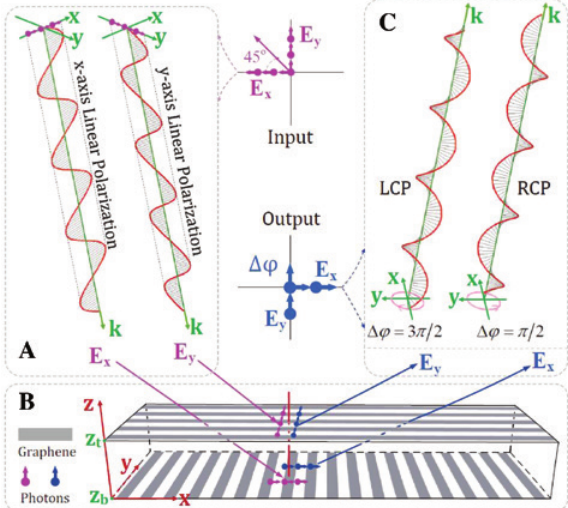
Figure 20: Dependence of the linear phase difference Δ φ on z determined for different values of the thickness of the insulator layer: d = 0.5 μ m (red line), d = 1 μ m (blue line), d = 1.5 μ m (green line), d = 2 μ m (purple line), and d = 2.5 μ m (cyan line). The solid lines and circles indicate the numerical and analytical results, respectively. Reproduced from Ref.